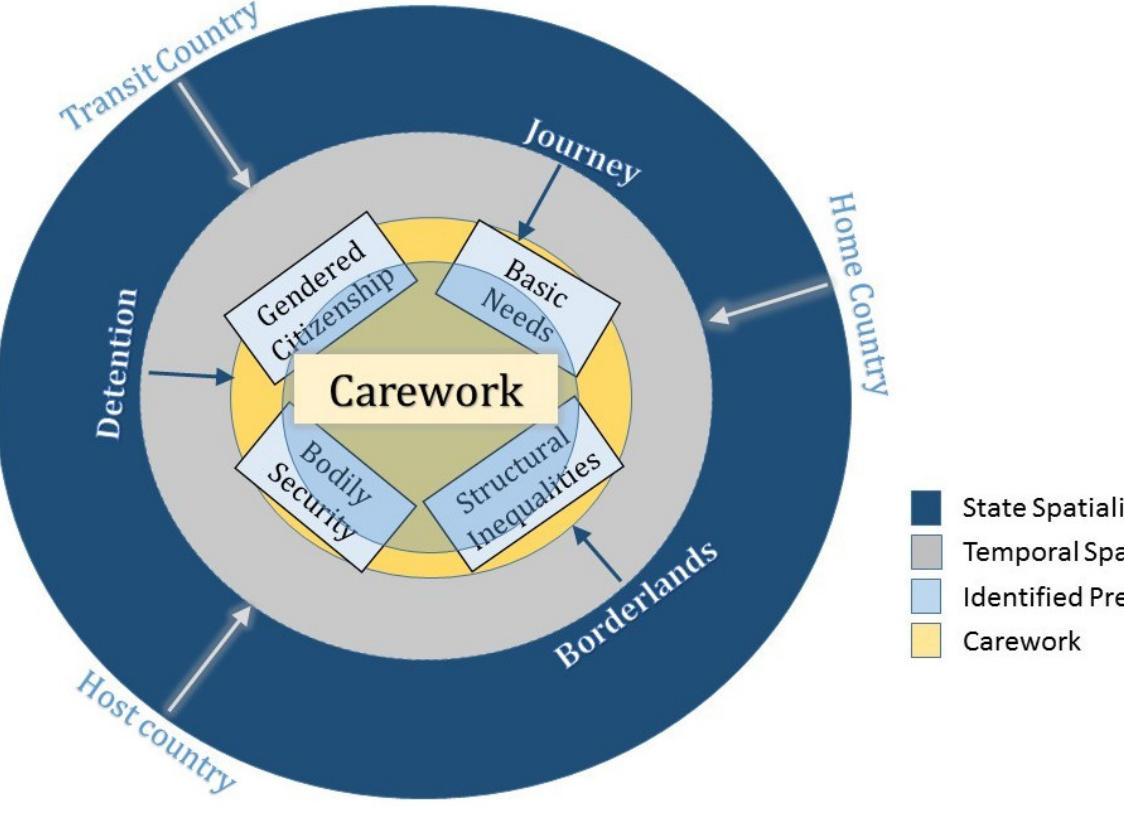
Figure 1. Dial of Carework